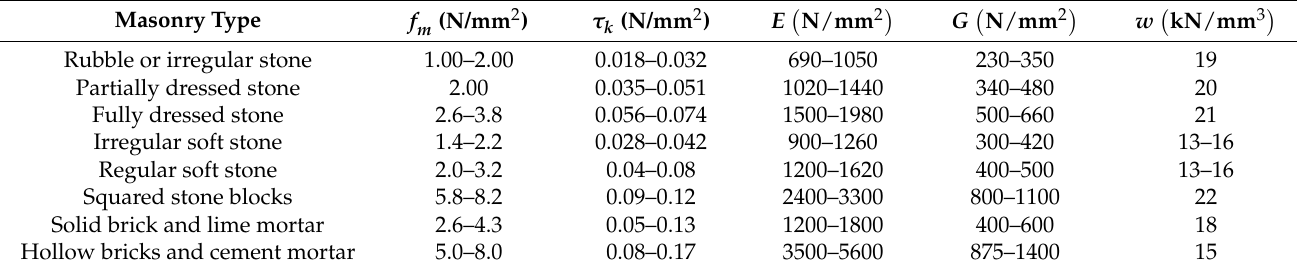
Table 1. Reference values of relevant properties of different types of masonry: compressive strength, f m ; shear strength, τ k ; elastic modulus, E ; shear modulus, G ; and specific weight, w (adapted from Table C8. 5. I of Italian Guidelines 2019 [19]). Masonry